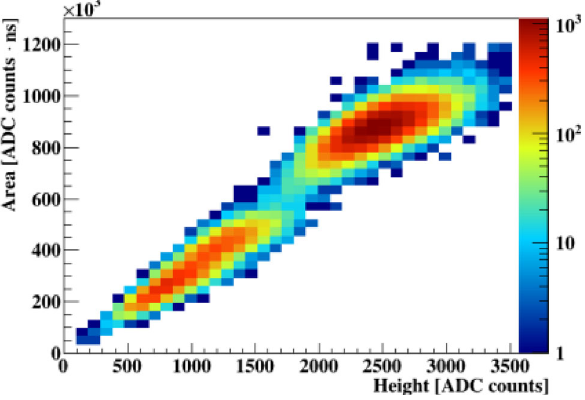
Fig. 11 Pulse area versus pulse height for events collected with the 241 Am source from the bottom SiPM